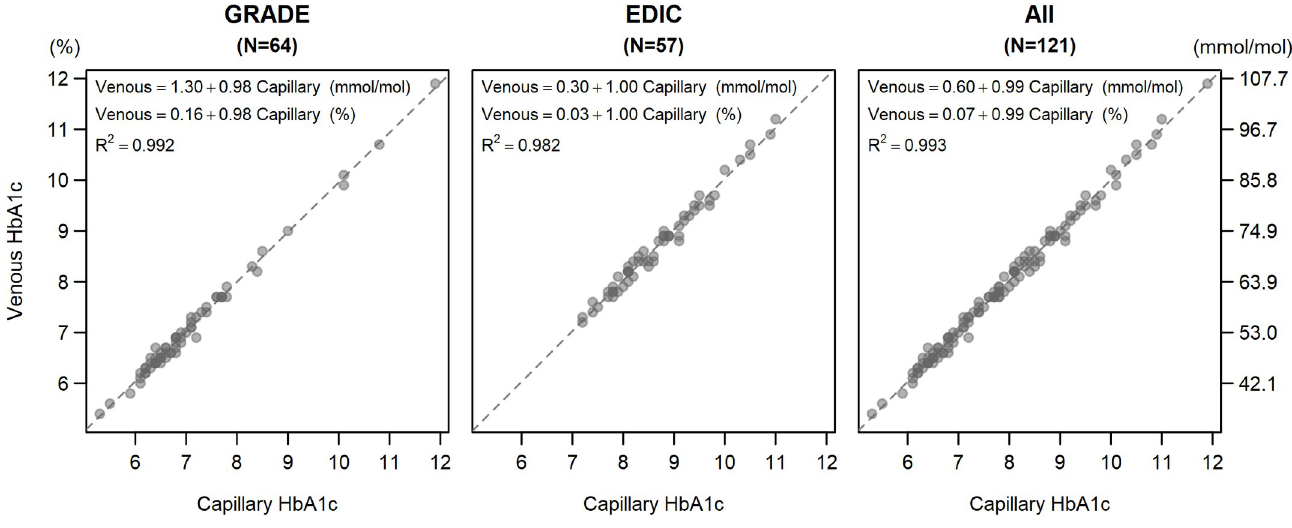
Fig 2. Regression plots of capillary and venous HbA1cs.